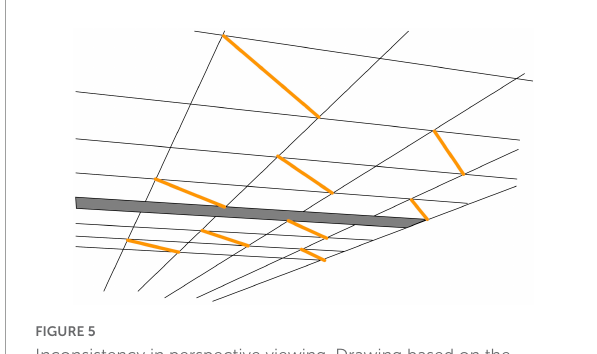
FIGURE5 Inconsistency in perspective viewing. Drawing based on the photograph in Kappers and te Pas (2001). Despite seeing a ceiling consisting of aligned square tiles and seeing that the orange lines are diagonals of such square tiles, the orange lines do not appear to be parallel. The figure obviously shows a two-dimensional rendition; Kappers and te Pas reported that the effect was even stronger in an actual room: the physically parallel fluorescent tubes appeared visually extremely